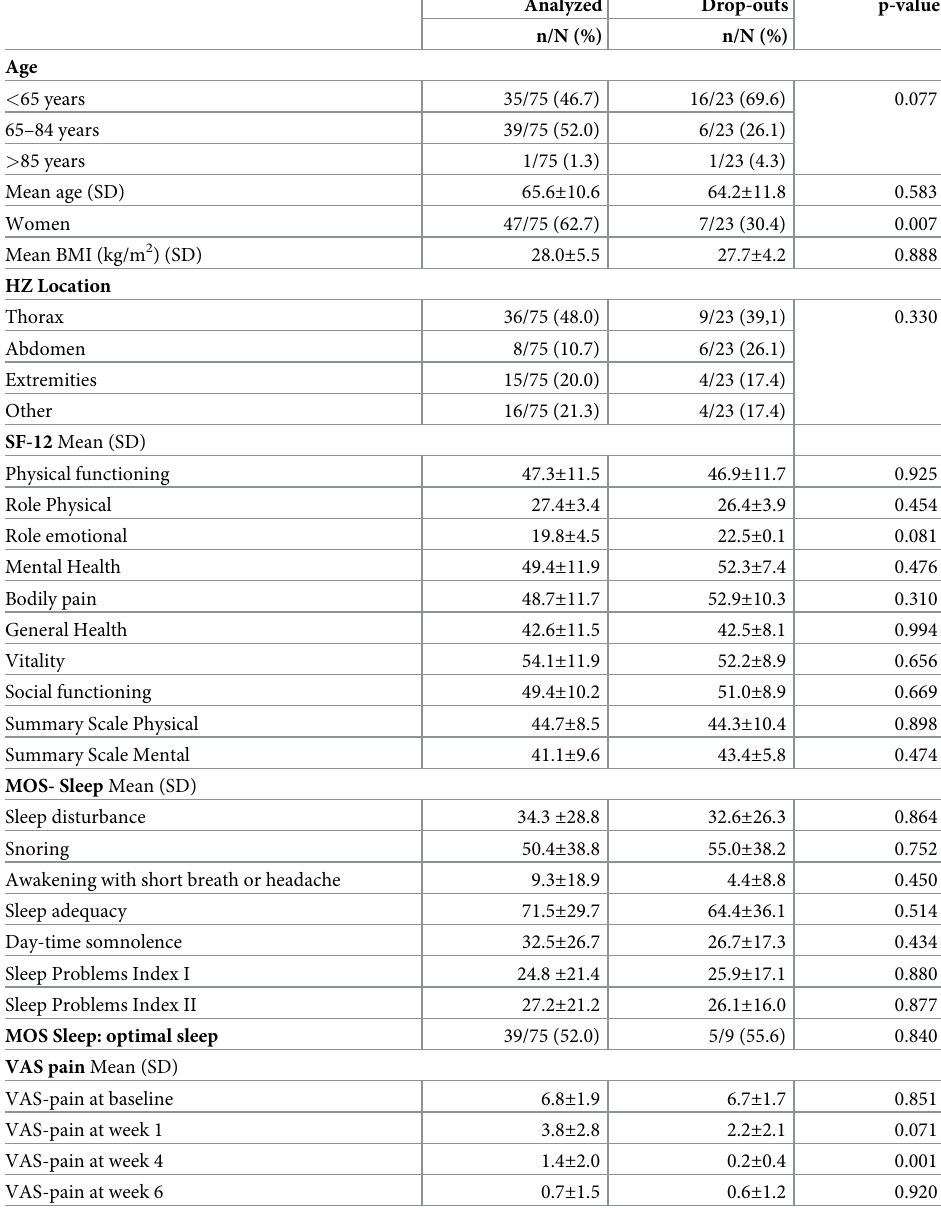
Table 6. Characteristics of patients who completed the trial and were analyzed, and of patients who withdrew. Analyzed Drop-outs